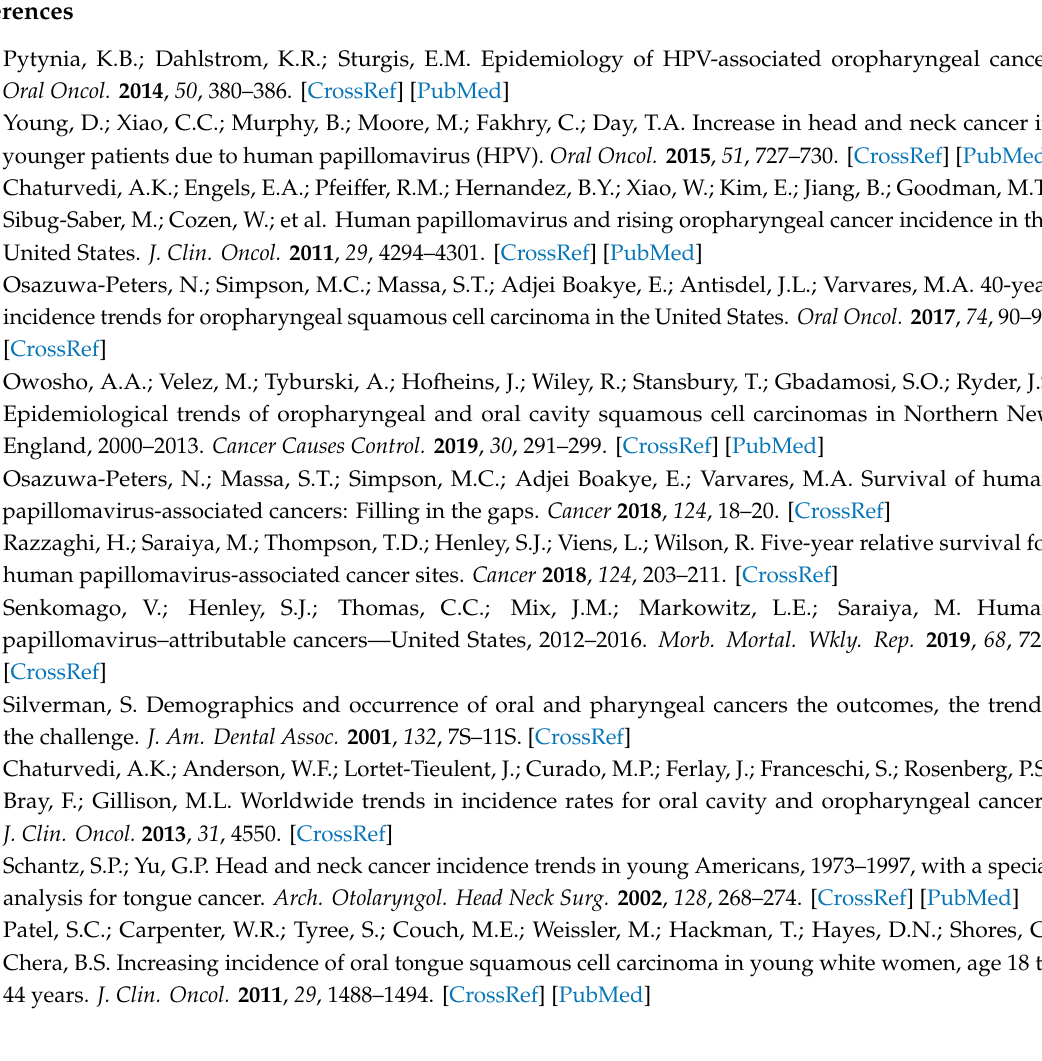
Figure S1: Observed average age at diagnosis by year and Joinpoint regression models by head and neck anatomic subsite, Table S1: Annual percentage changes and average annual percentage changes average age at diagnosis from 1975–2016 by head and neck anatomic